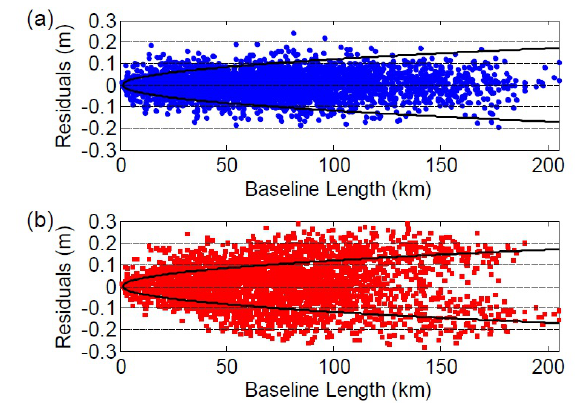
Figure 3: Mid Hunter residuals between (a) AUSGeoid09- and (b) AUSGeoid98-derived and oflcial AHD height differences over 3,320 possible vectors. The unbroken line describes the allowable 3 rd order differential levelling